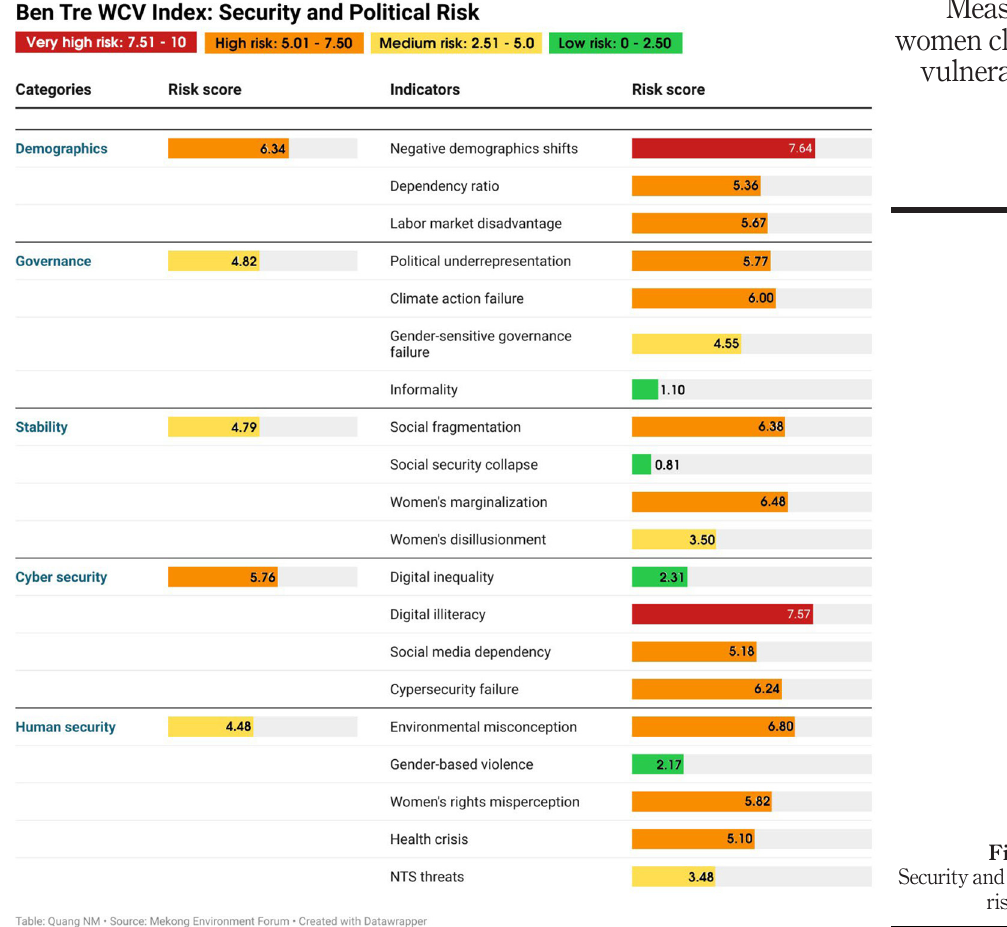
Figure 5. Security and political risk